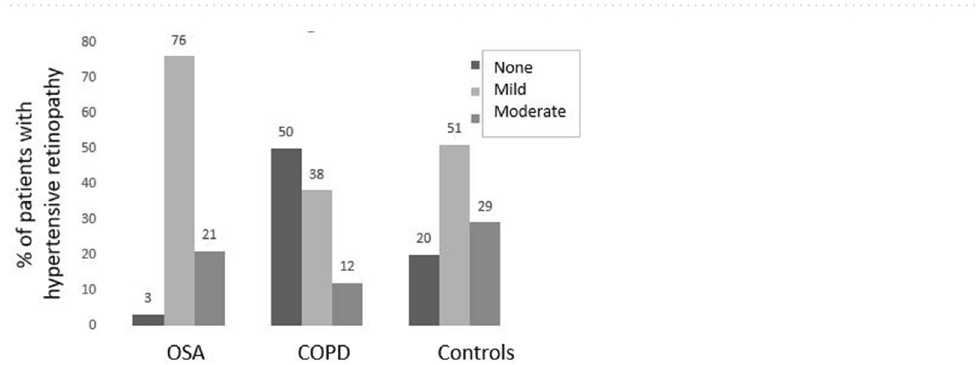
Figure 2. % of individuals with no, mild or moderate microvascular retinopathy in OSA, Controls and